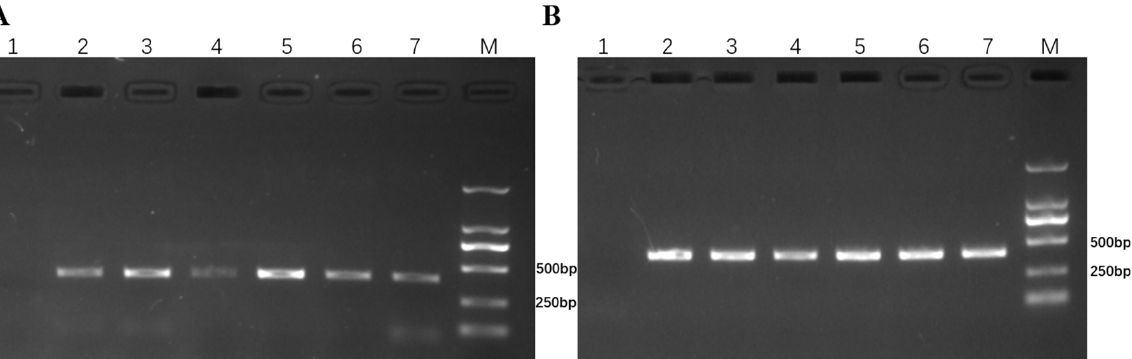
Figure 4. PCR results from primers KU88 and KU291. ( A ) PCR results from primer KU88. ( B ) PCR results from primer KU291. Lane 1: CN25 (wheat parent); Lane 2: Qinling rye; Lanes 3 and 4: 117-6 (T6RS.6AL translocation); 5: 6RS addition plant; 6: 6R monosomic addition plant; 7: heterozygous. M: marker DL2000.